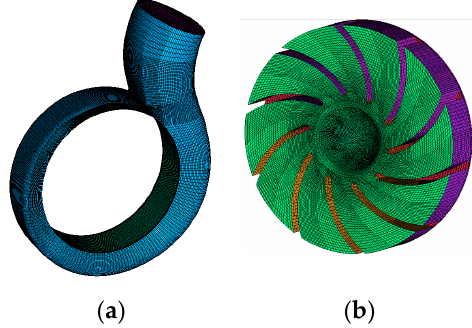
Figure 2. Sketch of the structured mesh: ( a ) volute; ( b ) impeller.